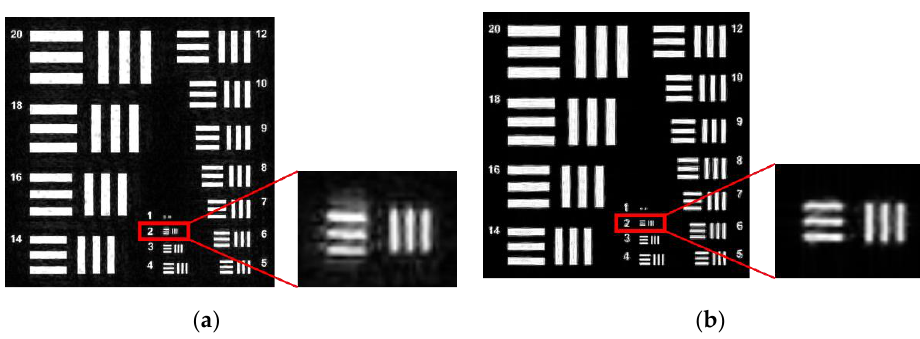
Figure 8. Partial enlargement of Figure 6. ( a ) Partially magnify the results of AMPR recovery; ( b )